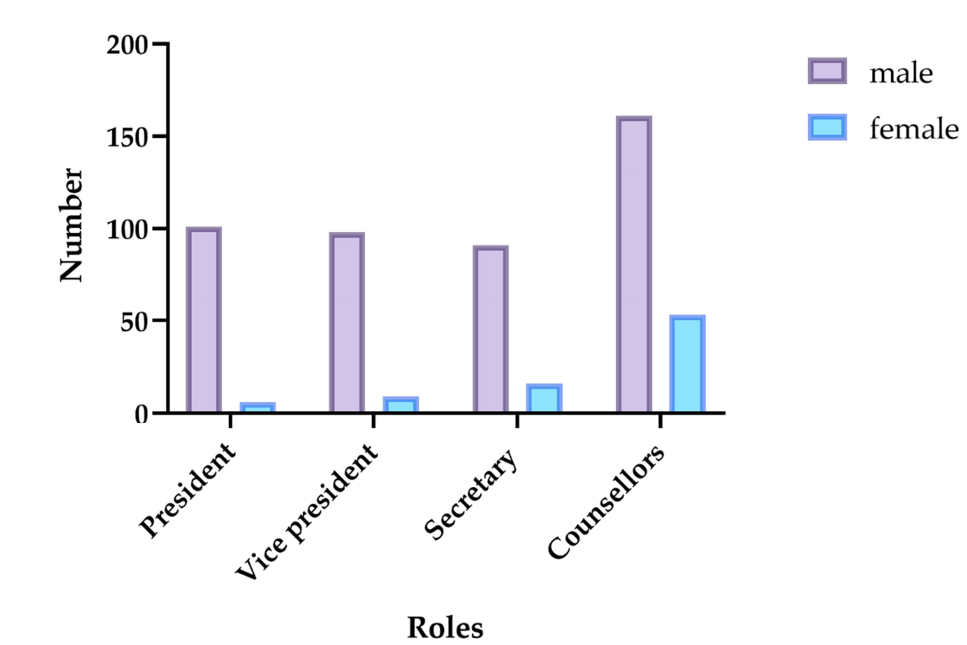
Figure 1. Graphical representation of the roles and gender distribution in national and local dental boards.